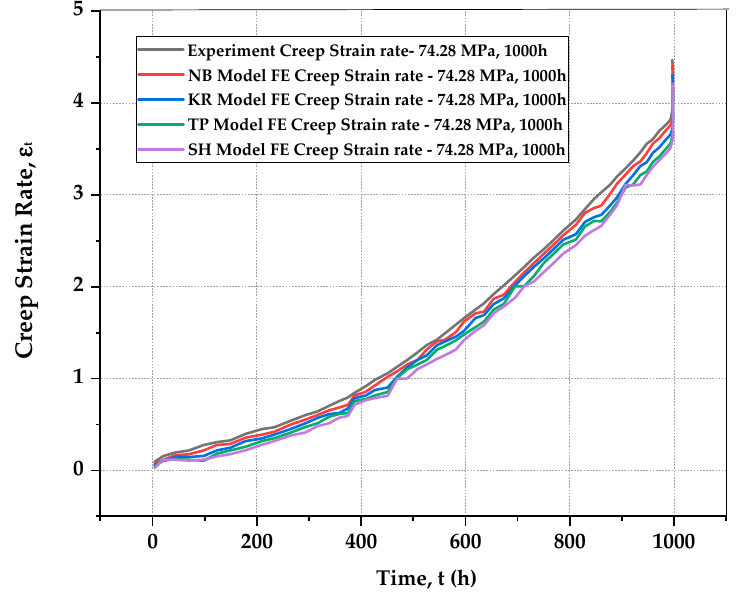
Figure 13. Comparison of FEM results with the creep experiment results for the five models . Table 5. Maximum percentage deviation between FE and creep experiment results for the mod- els .